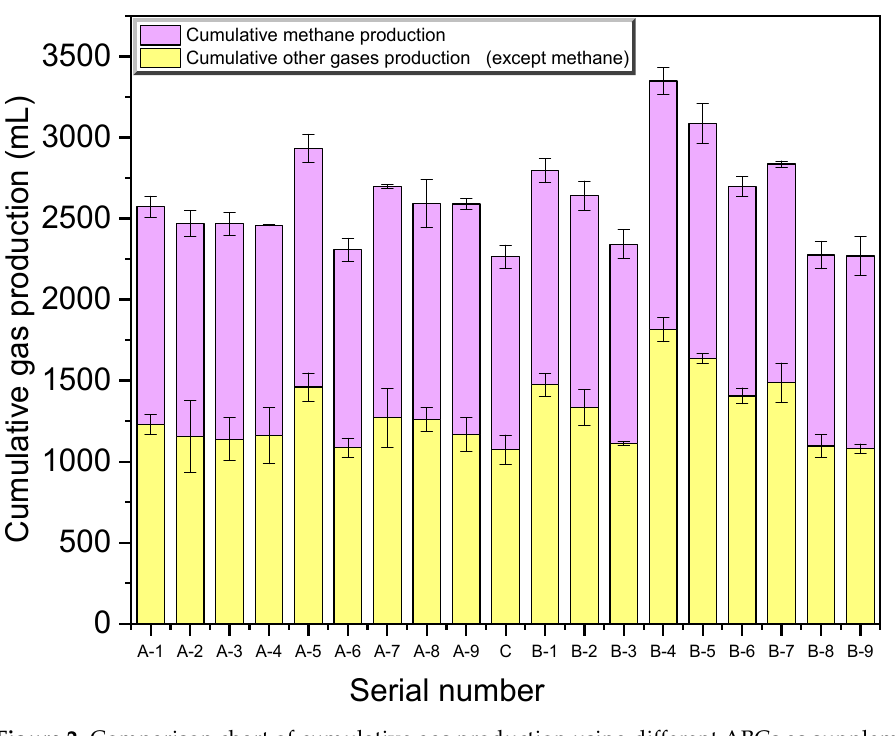
Figure 2. Comparison chart of cumulative gas production using different ABCs as supplement. Under the condition of obtaining the same cumulative gas production, the shorter the fermentation time, the better the fermentation effect, and the higher the methane pro- duction efficiency. Figure 3 shows the change in cumulative methane production. The time when the cumulative methane production accounted for 80% of the total methane production during the whole fermentation cycle was as follows: Group C was the 22nd day, Group A was the 20th to 21st day, and Group B was the 20th to 21st day. The best ones were A-5 and B-4, the proportion of which reached 81.6 and 81.19% on the 22nd and 15th day respectively. The results showed that ACB could not only increase methane pro- duction, but also shorten the fermentation period, and the optimization effect of PACB was better than CACB; this is highly consistent with the results of Sunyoto’s research [33].